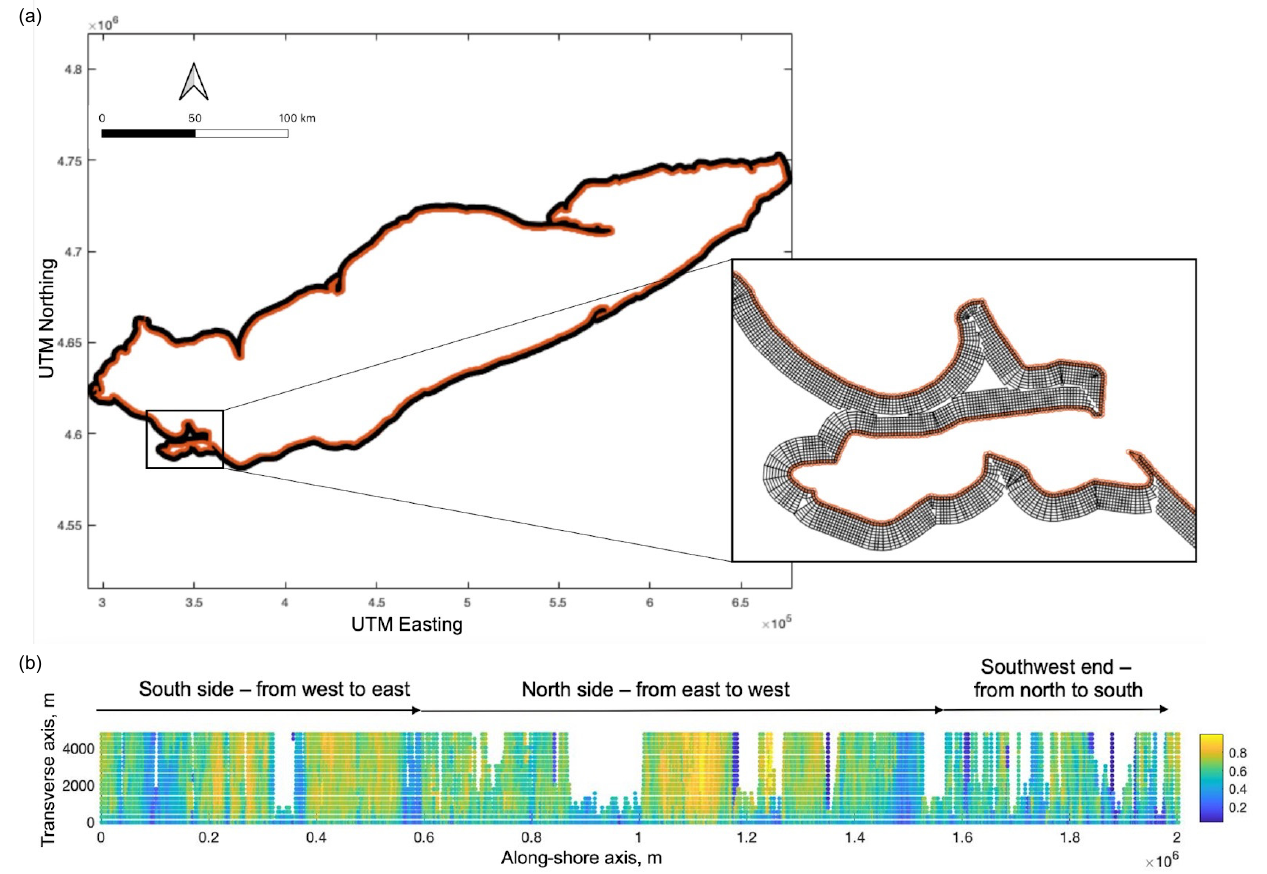
Figure 3. ( a ) Lake Erie’s grid, the entire grid on the left, and zoom on the Portage River region, where we can see the transverse and longitudinal axis on the right; ( b ) scatter plot of the 2001 peak EVI extracted on the grid. The x -axis is the distance along the shoreline, and the y -axis is the distance from the shoreline. We can see some regions without points, which are located in peninsulas .